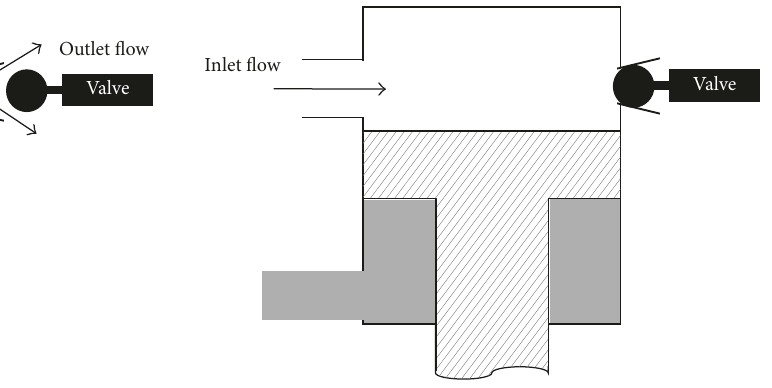
Figure 7: Piston control mechanism with ball valve.